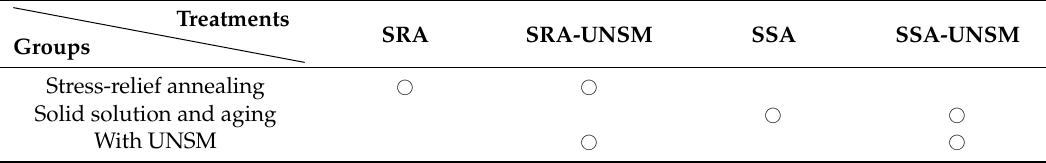
Table 1. Groups of specimen. SRA: stress-relief annealed; SSA: solid solution-aging; UNSM: ultrasonic nanocrystal surface modification.